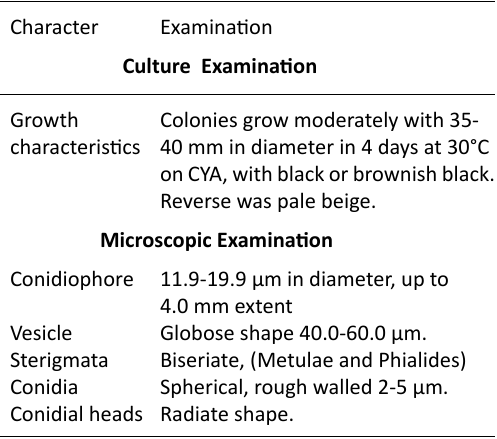
Table 1. Culture and microscopic characteristics of fungal isolate (MEKKY A1) growing on CYA